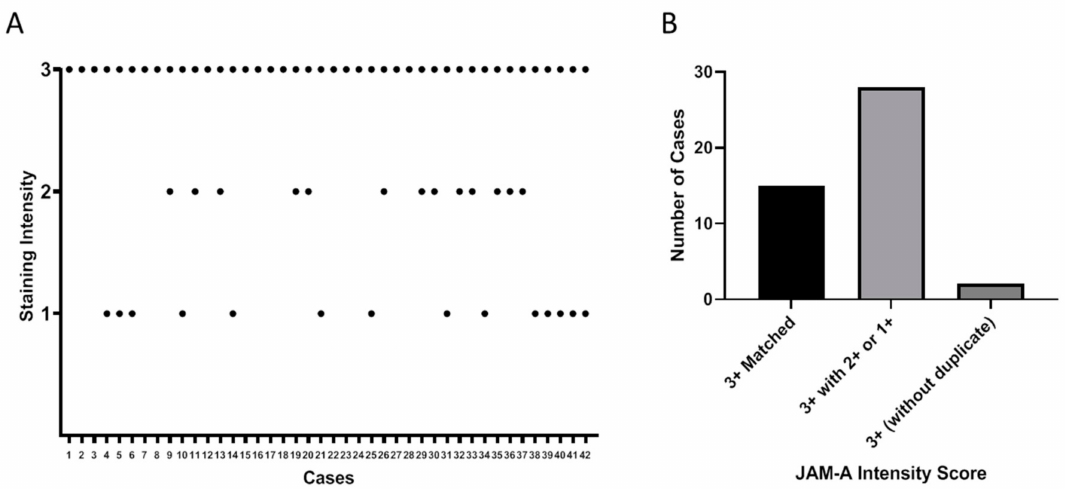
Figure 3. JAM-A protein expression is heterogeneous across duplicate cores. Duplicate cores assessed showed discordance within 43 individual cases ( A , B ), where at least one core scored 3+ for JAM-A protein expression